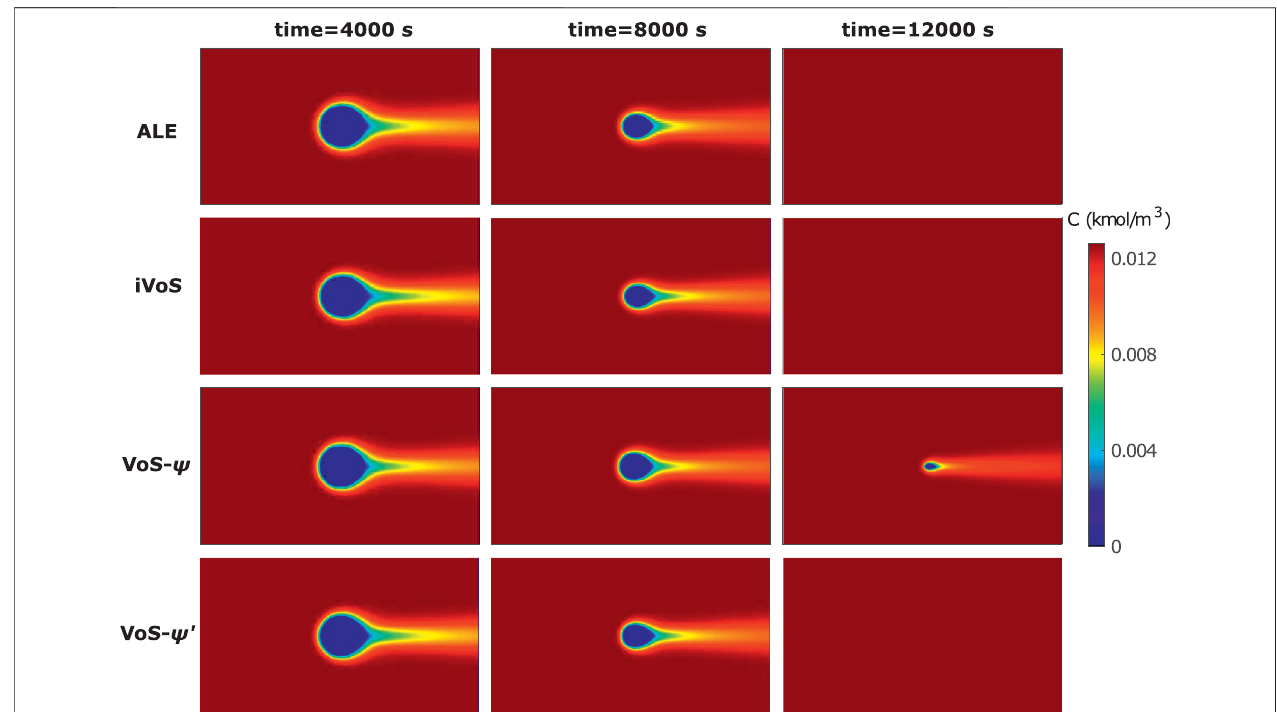
FIGURE 1 | Concentration map at various times during dissolution of a calcite post by acid injection using the ALE, VoS- ψ , VoS- ψ ’ and iVoS methods.